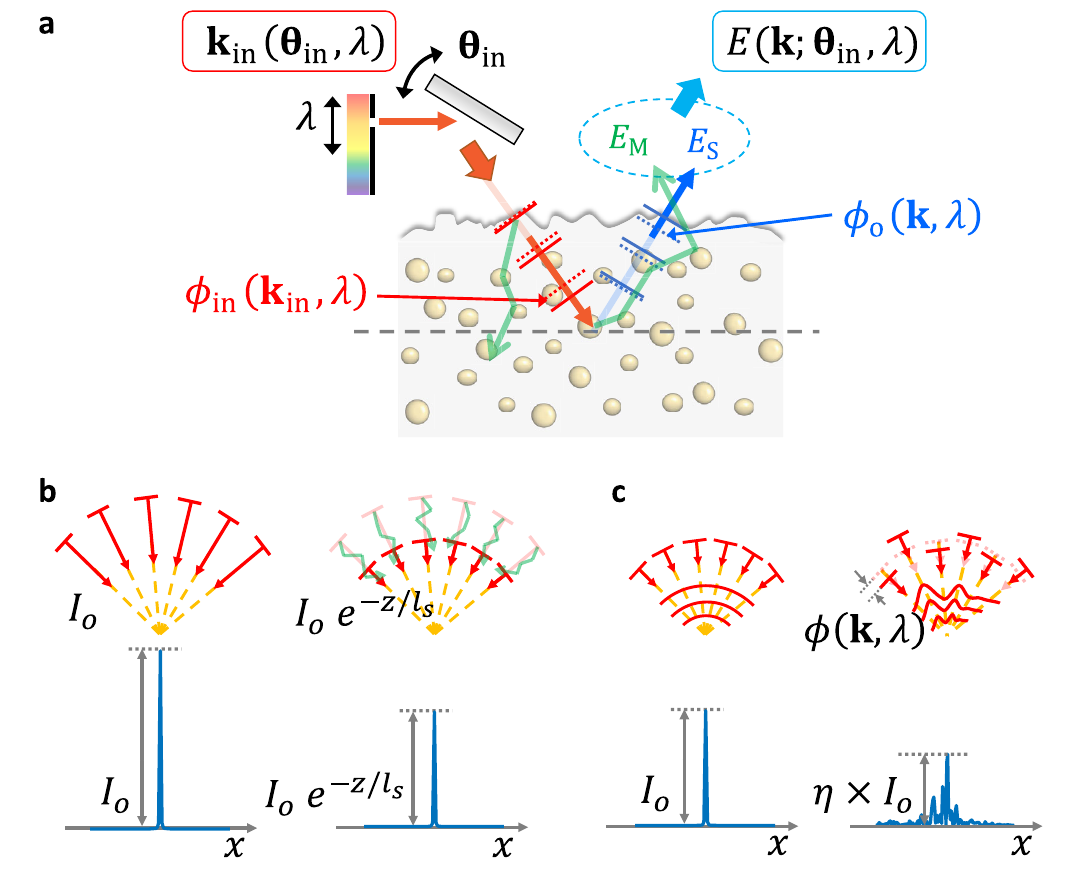
Fig.1|Effectsofmultiplescatteringandspectro-angulardispersionsonimage formation. a Foranincident planarwave withincidenceangle θ in and wavelength λ , its small fraction termed a ballistic wave indicated by a red arrow propagates straight through the scattering medium while maintaining its incident wavevector (cid:1) (cid:3) = 2 π λ sin θ in . The rest indicated by a green arrow contribute to set by k in θ in , λ multiple-scattered waves. The incident ballistic wave is scattered by an object on thesampleplanetoawavevector k